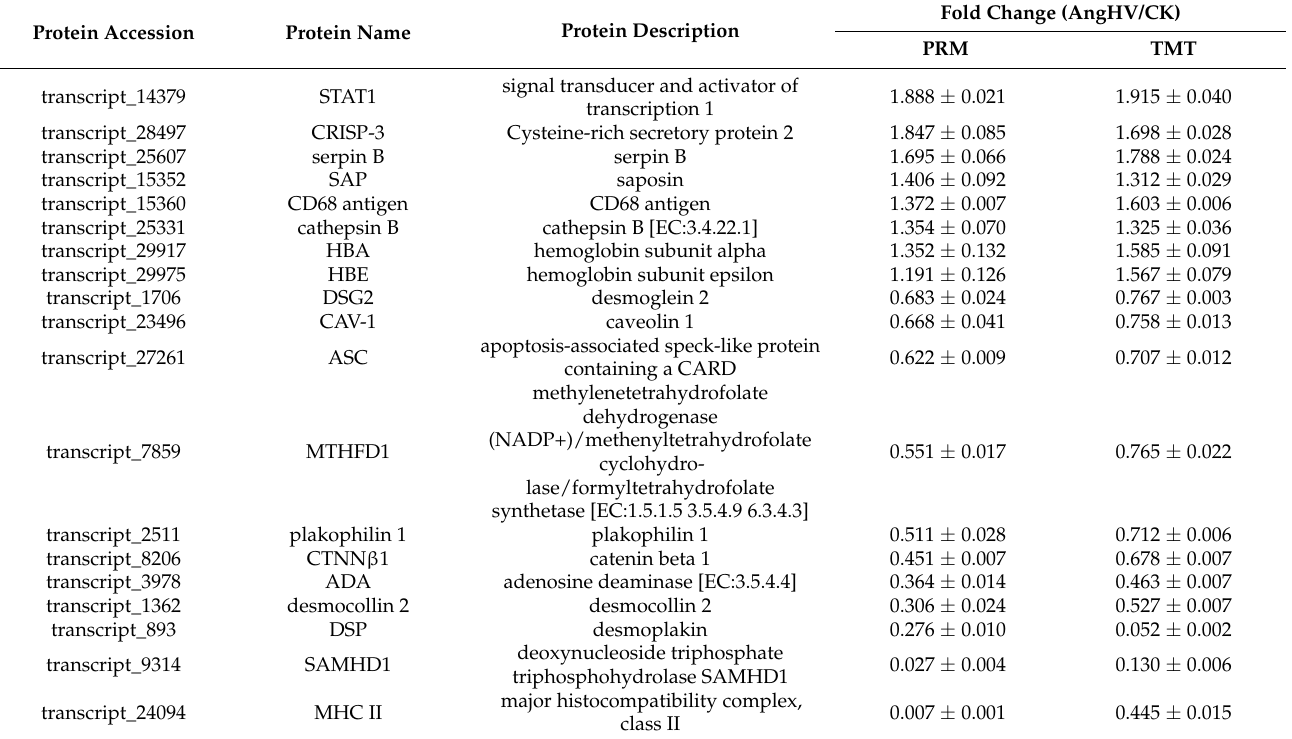
Table 2. The result of the DEP detection by